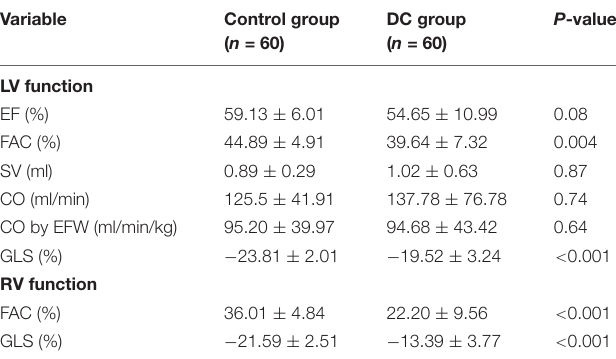
TABLE 3 | Fetal functional echocardiographic parameters in the study